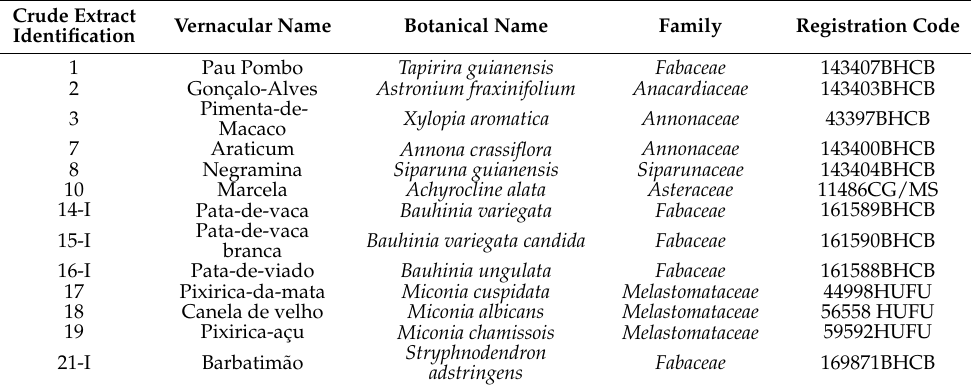
Table 8. Classification of natural extracts from the Brazilian cerrado